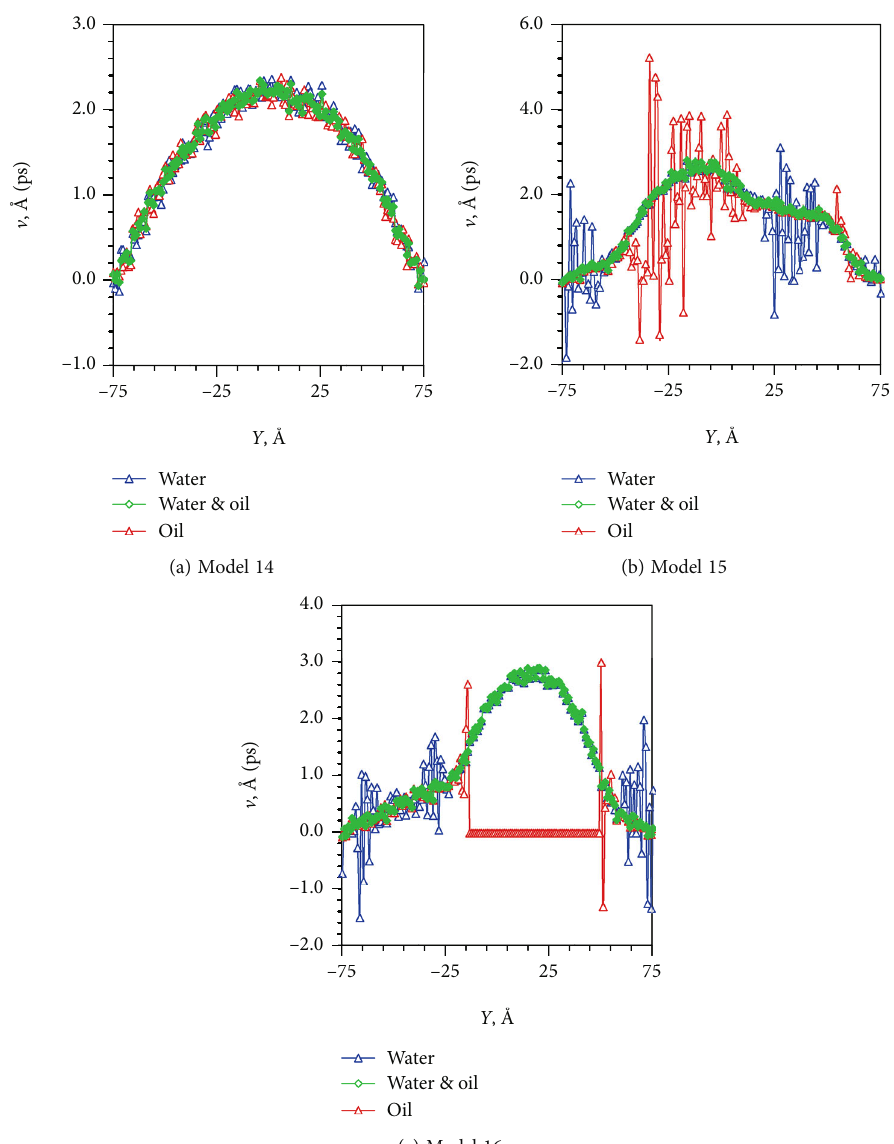
Figure 16: Velocity pro fi le along the X -axis of models of di ff erent conservative force between oil and